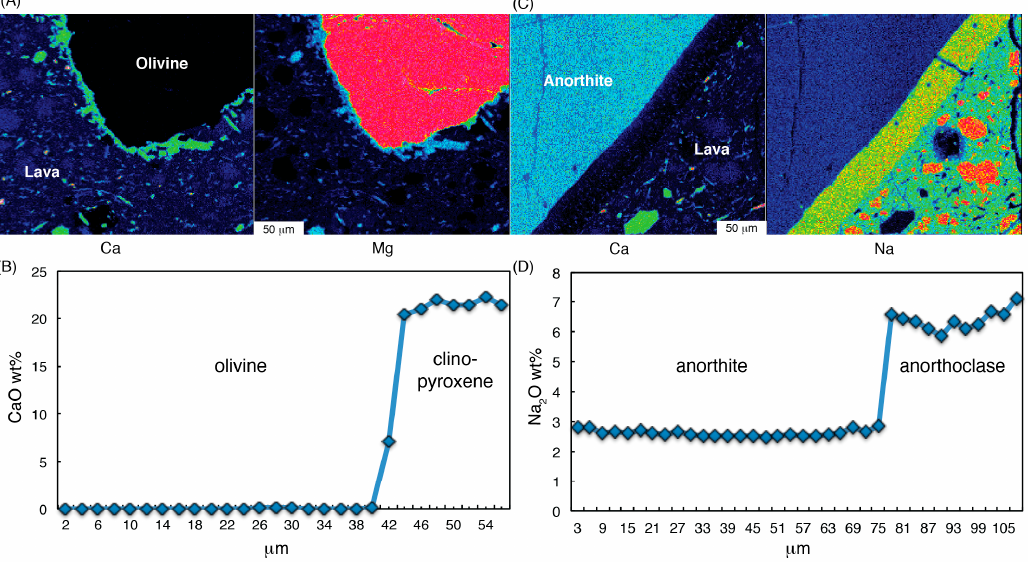
Figure 5. WDS element maps and geochemical traverses showing xenolith-magma contacts. ( A and B ) Olivine lacking Ca with high Mg has a 12 μ m contact zone of clinopyroxene with high Ca and